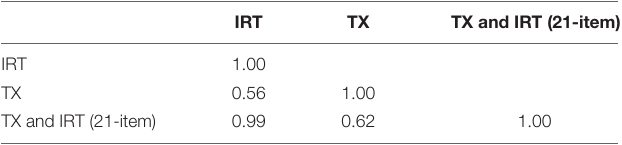
TABLE 2 | Correlations among estimates from three approaches: IRT, TX, and a combination of TX and IRT (21-item). IRT TX TX and IRT (21-item)